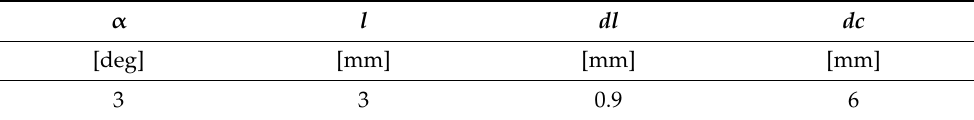
Table 2. Chosen scale pattern geometrical parameters.